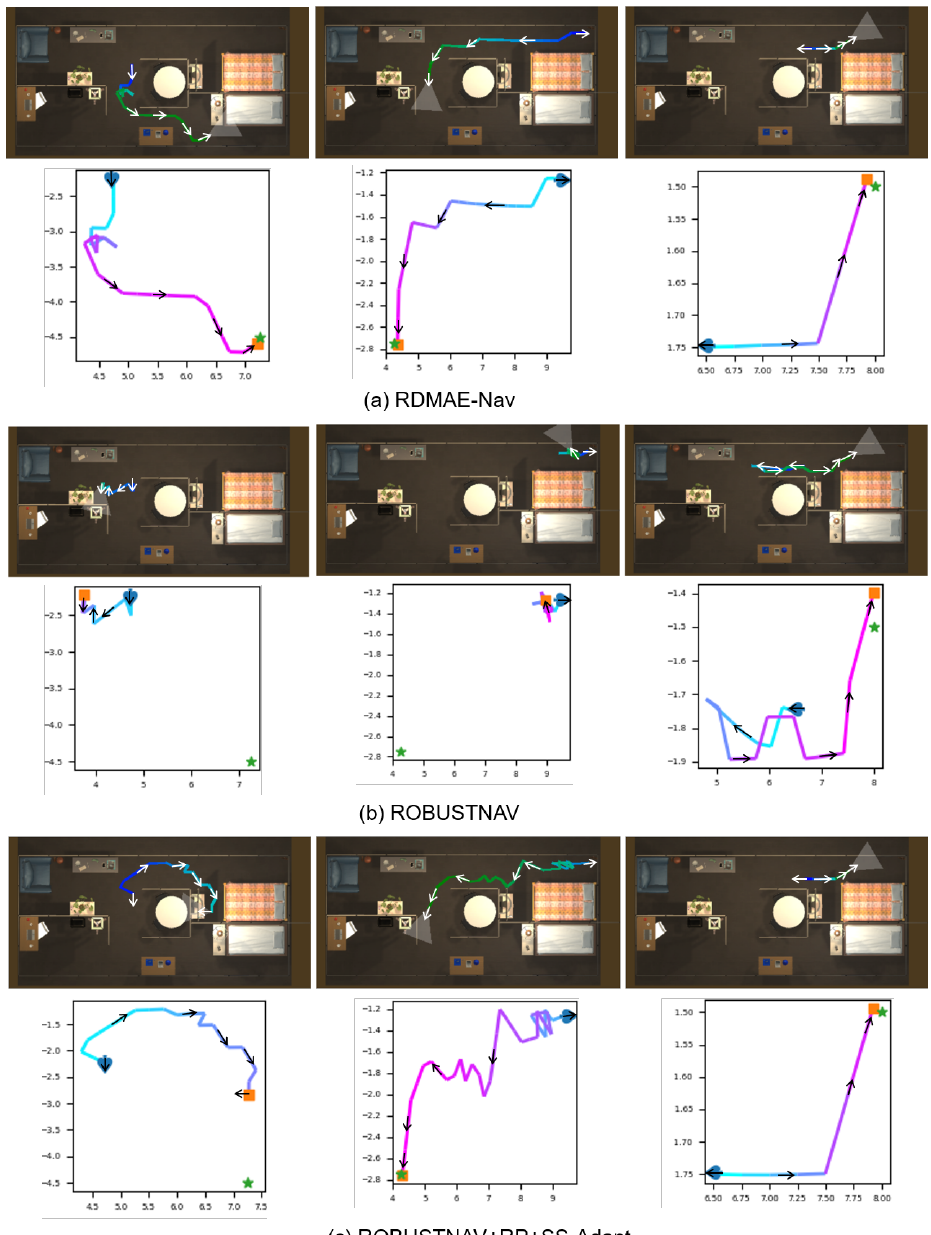
Figure 9. Examples of evaluated navigation trajectory visualization of RDMAE-Nav, ROBUSTNAV, and ROBUSTNAV+RP+SS-Adapt under